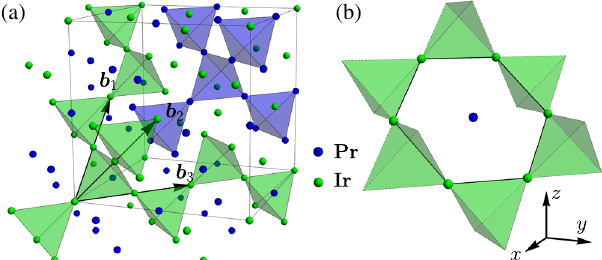
FIG. 1. The pyrochlore lattice structure for Pr 2 Ir 2 O 7 . (a) Both Ir and Pr ions form pyrochlore lattices of corner-sharing tetrahedra. (b) For each Pr ion, six nearest Ir ions form a hexagon with the Pr ion in the hexagon